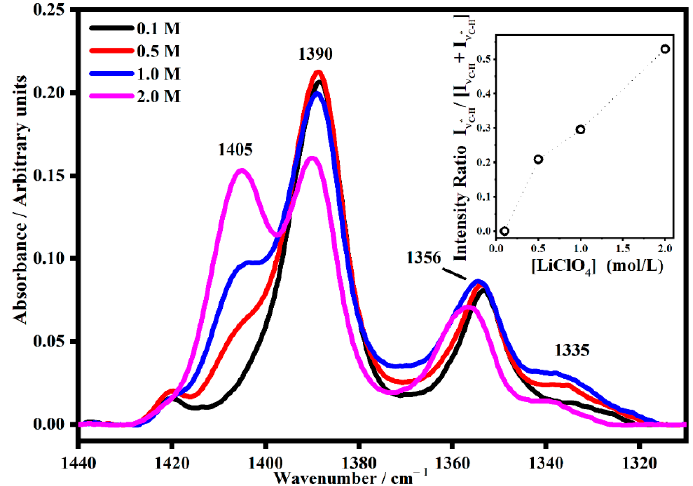
Figure 9. The IR band assigned to the CH 2 wagging mode denominated ν C-H (~1388 cm − 1 ) and its satellite band at ν C-H* (~1402 cm − 1 ) in PMMA-Li-PC-EC gel polymer electrolyte at different salt concentrations: 0.1 M, 0.5 M, 1 M and 2 M. In the inset, the trend of the intensity ratio I ν C-H* /[I ν C-H + I ν C-H* ] as a function of the salt concentrations.